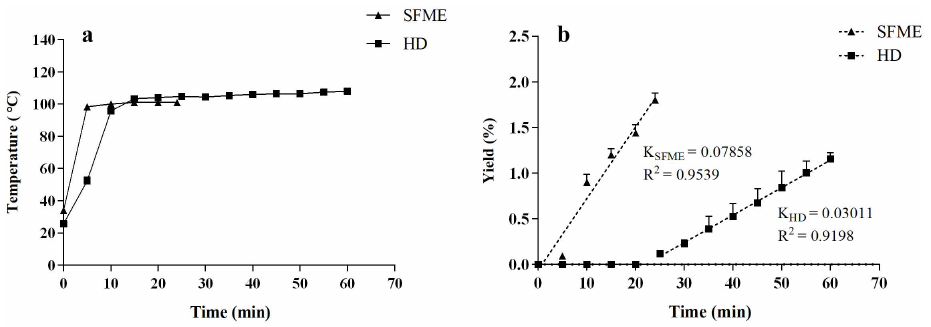
Figure 4. Comparison of extraction ( a ) temperature and ( b ) kinetics between solvent-free microwave extraction (SFME) and hydrodistillation (HD) processes.